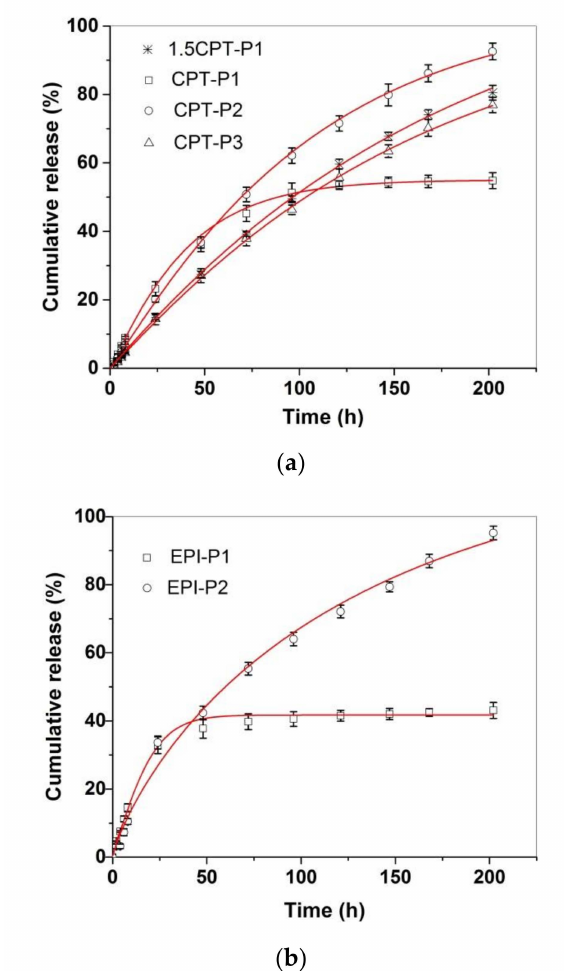
Figure 4. In vitro release profiles of ( a ) CPT-loaded aggregates and ( b ) EPI-loaded aggregates in PBS (pH 7.4) at 37 ◦ C, adjusted to a SWeibull2